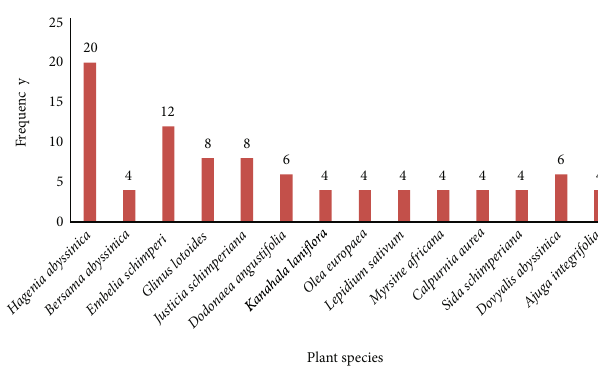
Figure 3: Frequently used plant species for the treatment of gastrointestinal parasitosis.